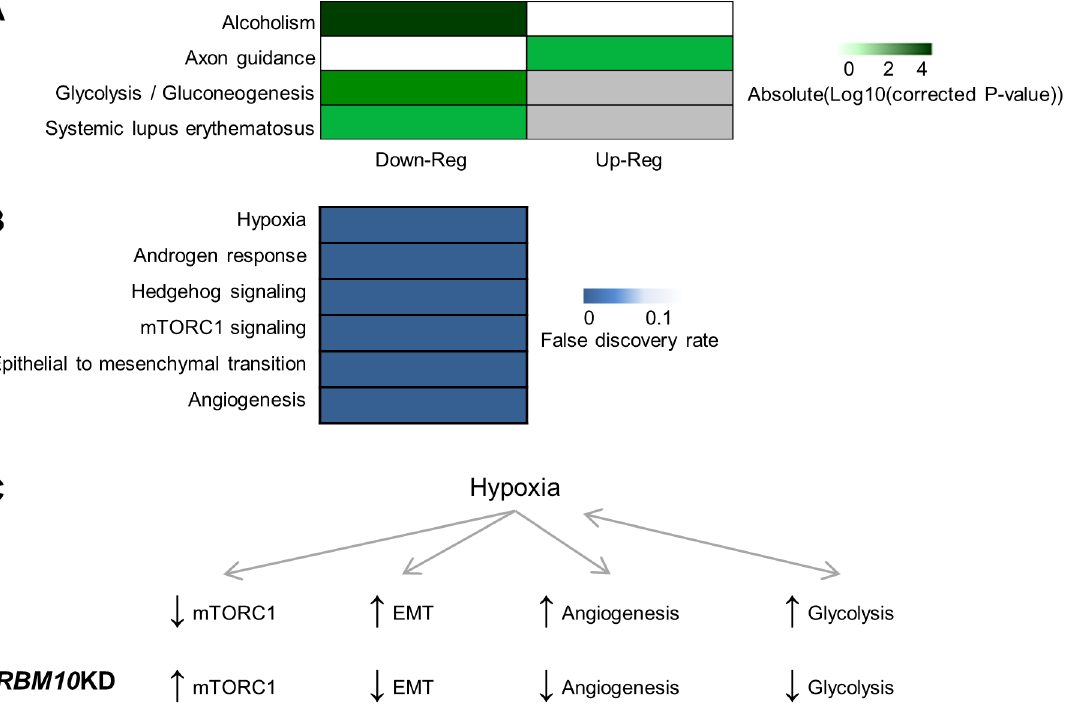
Fig 4. Pathway analysis of genes differentially expressedupon RBM10KD in GLC20 cells. (A) KEGG pathways significantly enrichedupon RBM10KD in GLC20 cells. Analysis performed using sublineRNA-Seqexpressiondata and the FIDEA pathways analysisprogram. (B) MSigDB Hallmarkgene sets enriched at a false discoveryrate of below 5% upon RBM10KD in GLC20 cells. Analysis performed using sublineRNA-Seqexpressiondata and the GSAASeqSP pathway analysisprogram. (C) Relationship between select RBM10-altered pathways in GLC20 cells. Hypoxia is associatedwith decreasedlevels of mTORC1 signaling,and promotionof EMT and angiogenesis. In addition, hypoxia is